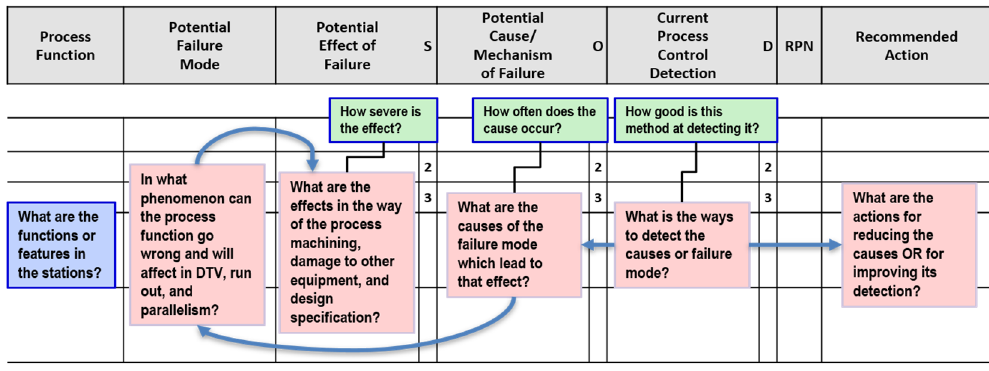
Figure 4. Design of the failure mode and effects analysis (FMEA) datasheet.